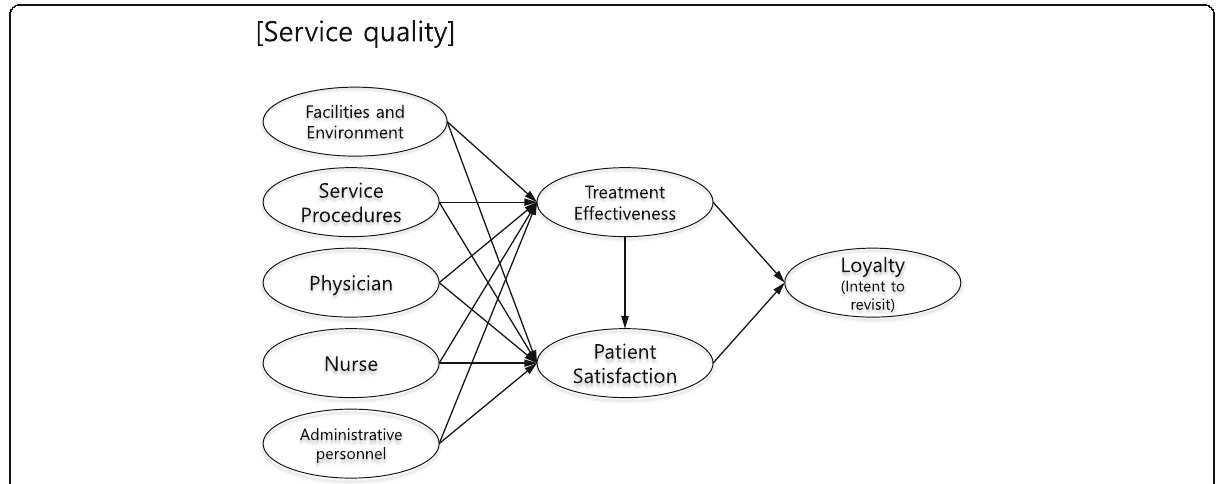
Fig. 1 Initial structural model drawn based on theoretical relationships. Service quality = facilities and environment, service procedures, physician, nurse, and administrative